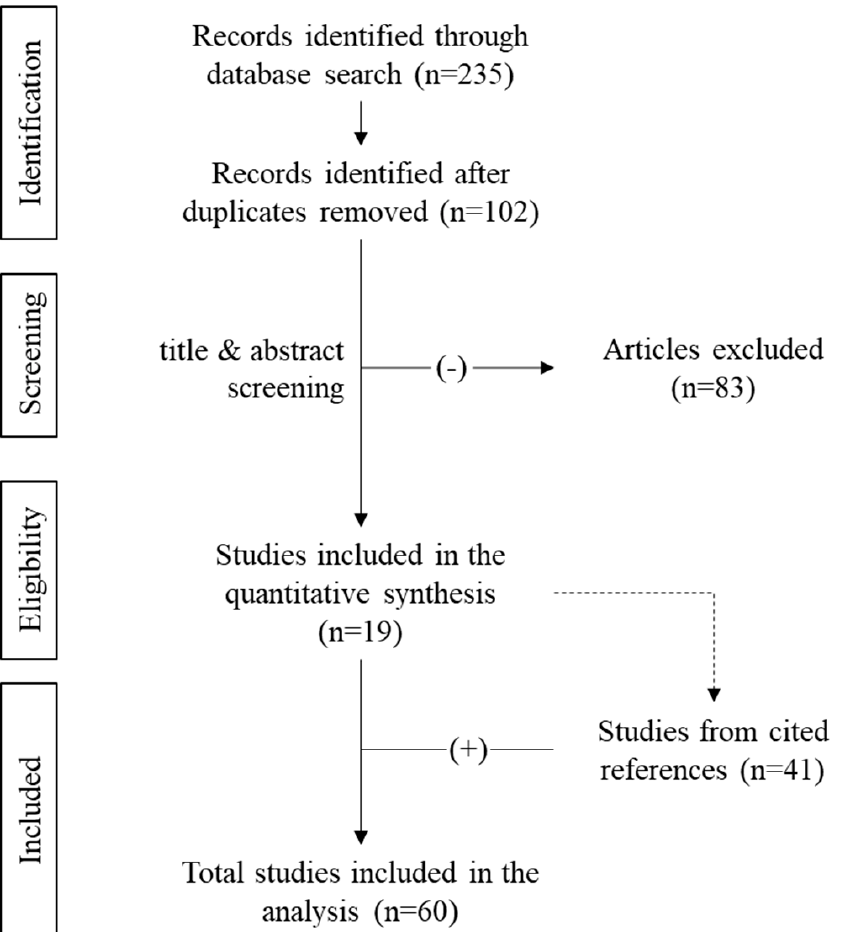
Figure 1. Study selection for review: Illustration of literature search and selection with numbers of articles at each stage.